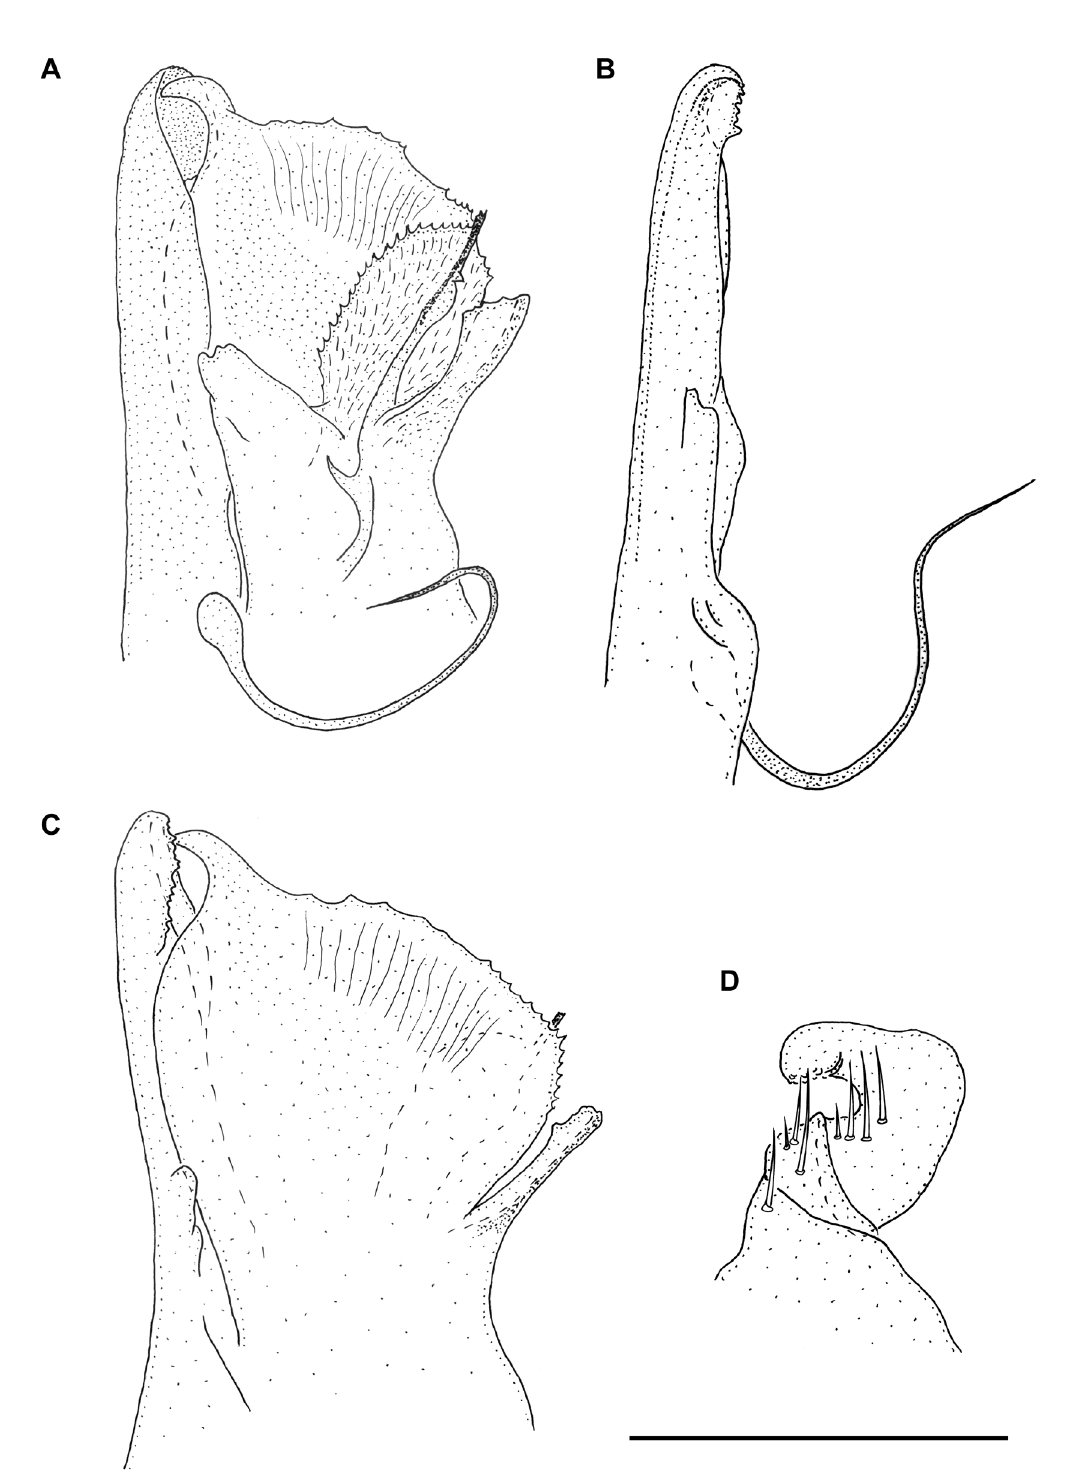
Fig. 10. Leucogeorgia longipes Verhoeff, 1930, ♂ from Kotias Cave (IZISU). A . Left gonopods, mesal view. B . Right promere, lateral view. C . Left gonopods, lateral view (flipped). D . Right leg 1, anterior view. Scale bar: 0.3